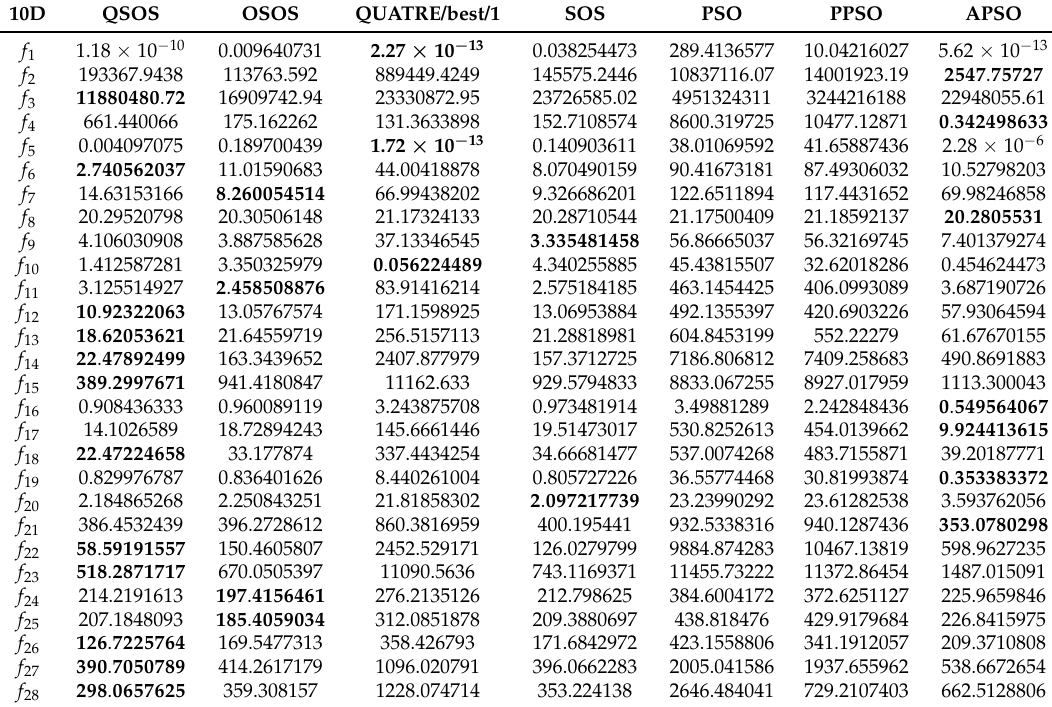
Table 2. The average result of 51 runs of the 28 test functions of CEC2013. OSOS: oppositional symbiotic organism search; SOS: symbiotic organism search; PSO: particle swarm optimization; PPSO: parallel PSO; APSO: adaptive